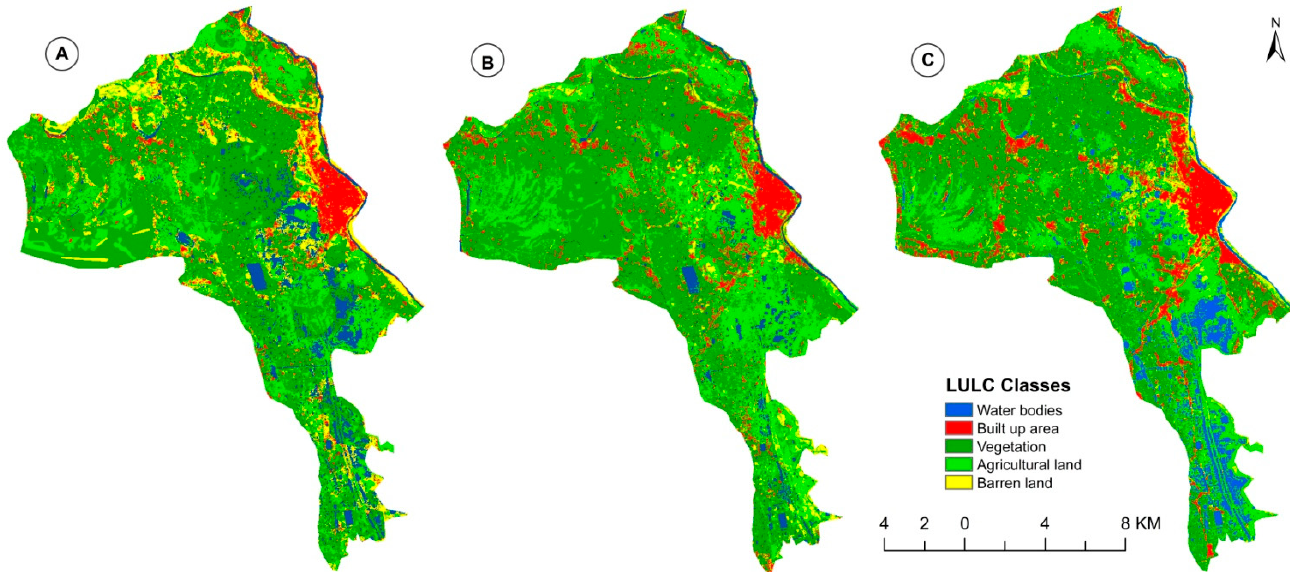
Figure 3. LULC mapping using SVM for the years of ( A ) 2001, ( B ) 2011, and ( C ) 2021 of the English Bazar block.